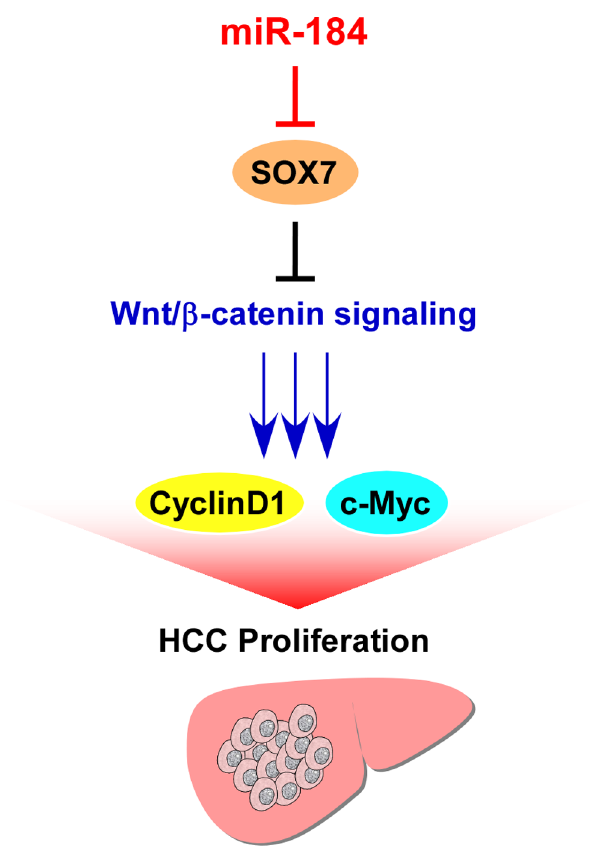
Figure 6. Proposed model. Upregulation of miR-184 represses SOX7 and promotes cell proliferation in